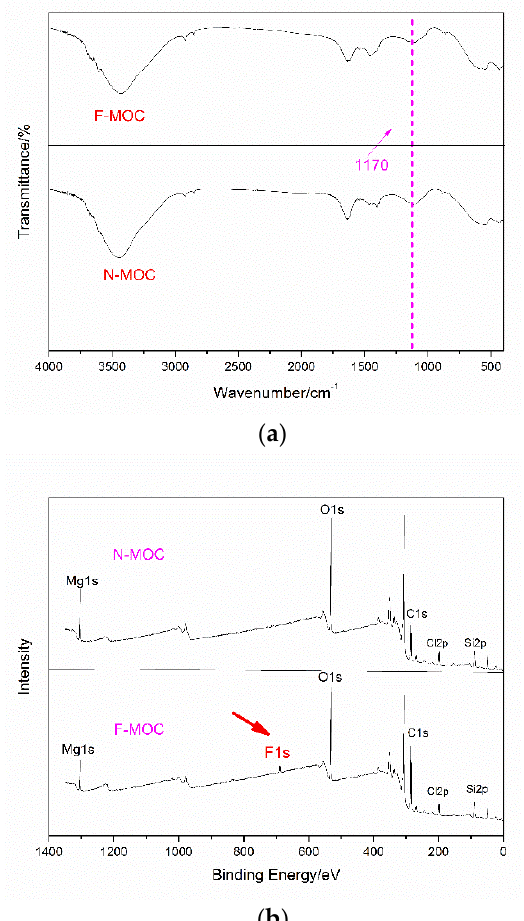
Figure 7. Fourier infrared test ( a ) and XPS spectrum ( b ) of F-MOC and N-MOC.